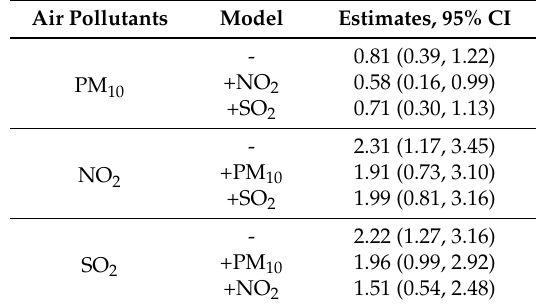
Table 3. Percent change (mean and 95% CI) in daily outpatient visits for eczema associated with 10 μ g/m 3 change in 7-day moving average air pollutant concentrations using both single-pollutant and two-pollutant models. Air Pollutants Model